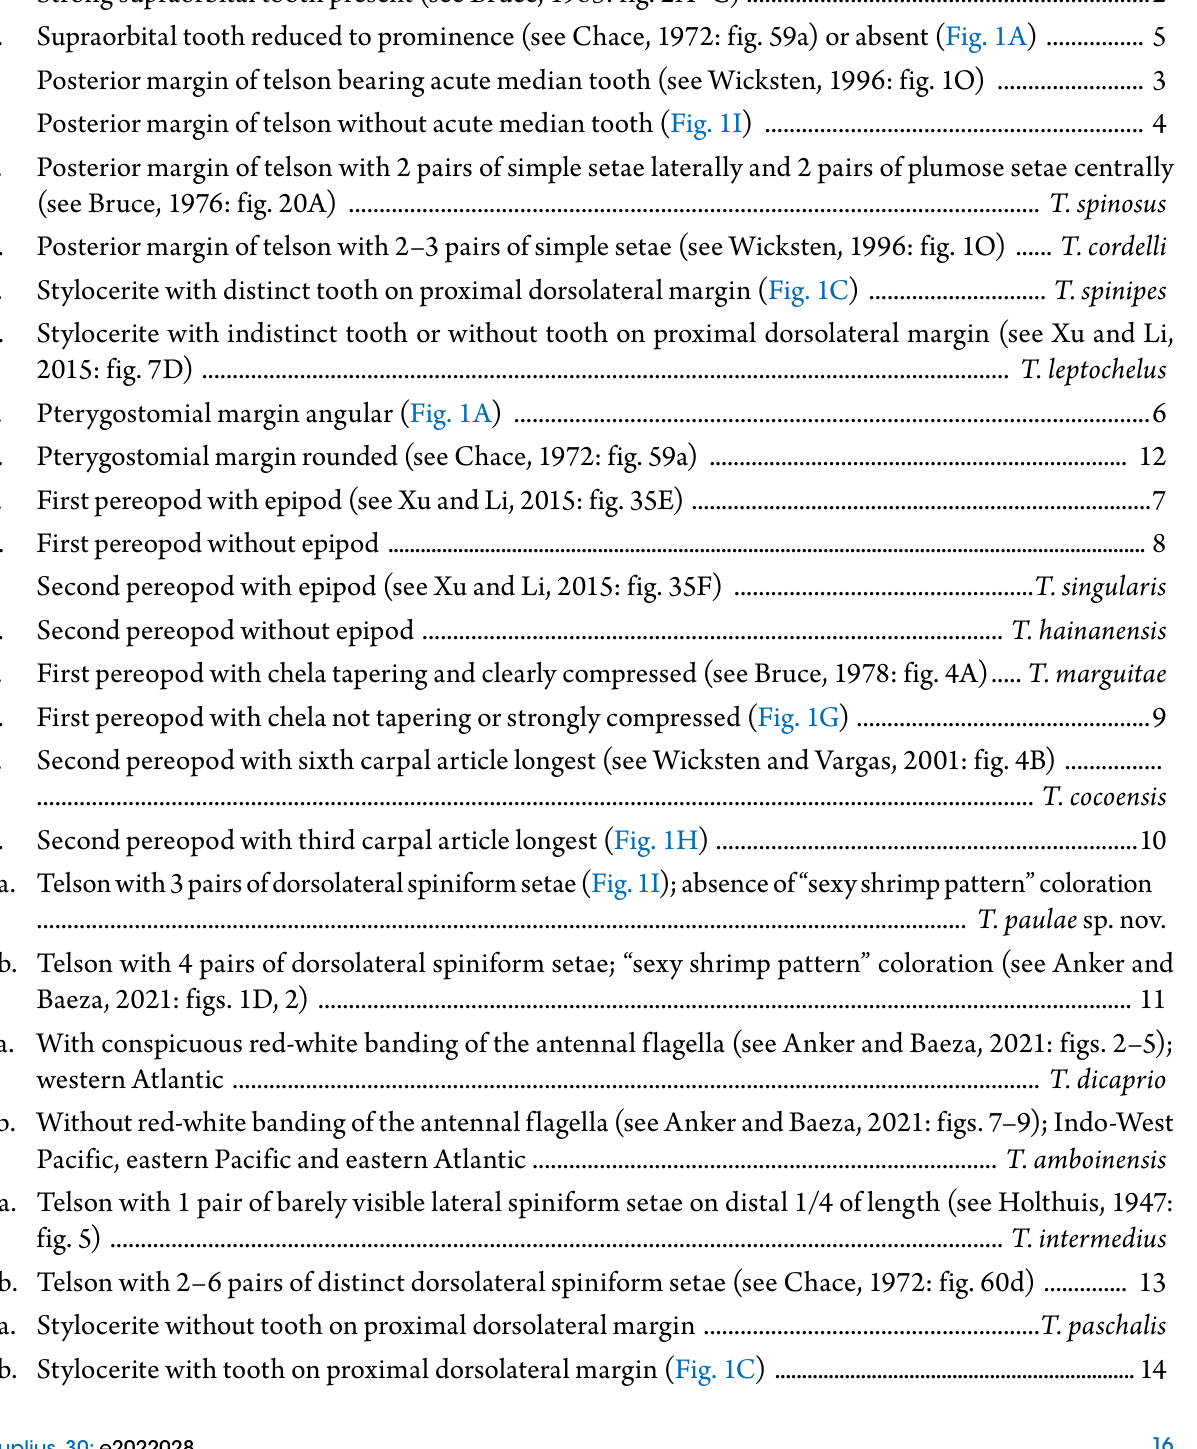
10a. Telson with 3 pairs of dorsolateral spiniform setae (Fig. 1I); absence of “sexy shrimp pattern” coloration 10b. Telson with 4 pairs of dorsolateral spiniform setae; “sexy shrimp pattern” coloration (see Anker and 11a. With conspicuous red-white banding of the antennal flagella (see Anker and Baeza, 2021: figs. 2–5); 11b. Without red-white banding of the antennal flagella (see Anker and Baeza, 2021: figs. 7–9); Indo-West 12a. Telson with 1 pair of barely visible lateral spiniform setae on distal 1/4 of length (see Holthuis, 1947: 12b. Telson with 2–6 pairs of distinct dorsolateral spiniform setae (see Chace, 1972: fig. 60d) .............. 13 13a. Stylocerite without tooth on proximal dorsolateral margin ....................................................... T. paschalis 13b. Stylocerite with tooth on proximal dorsolateral margin (Fig. 1C)